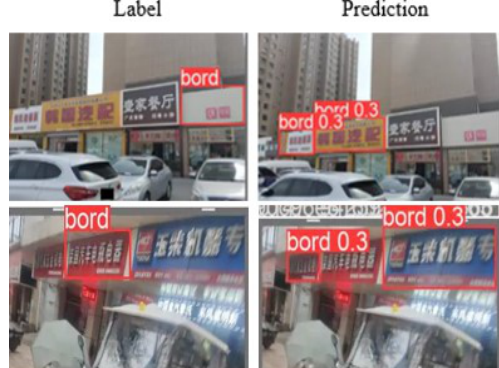
Figure 7. Example of test images with labelled (left) and predicted (right) bounding